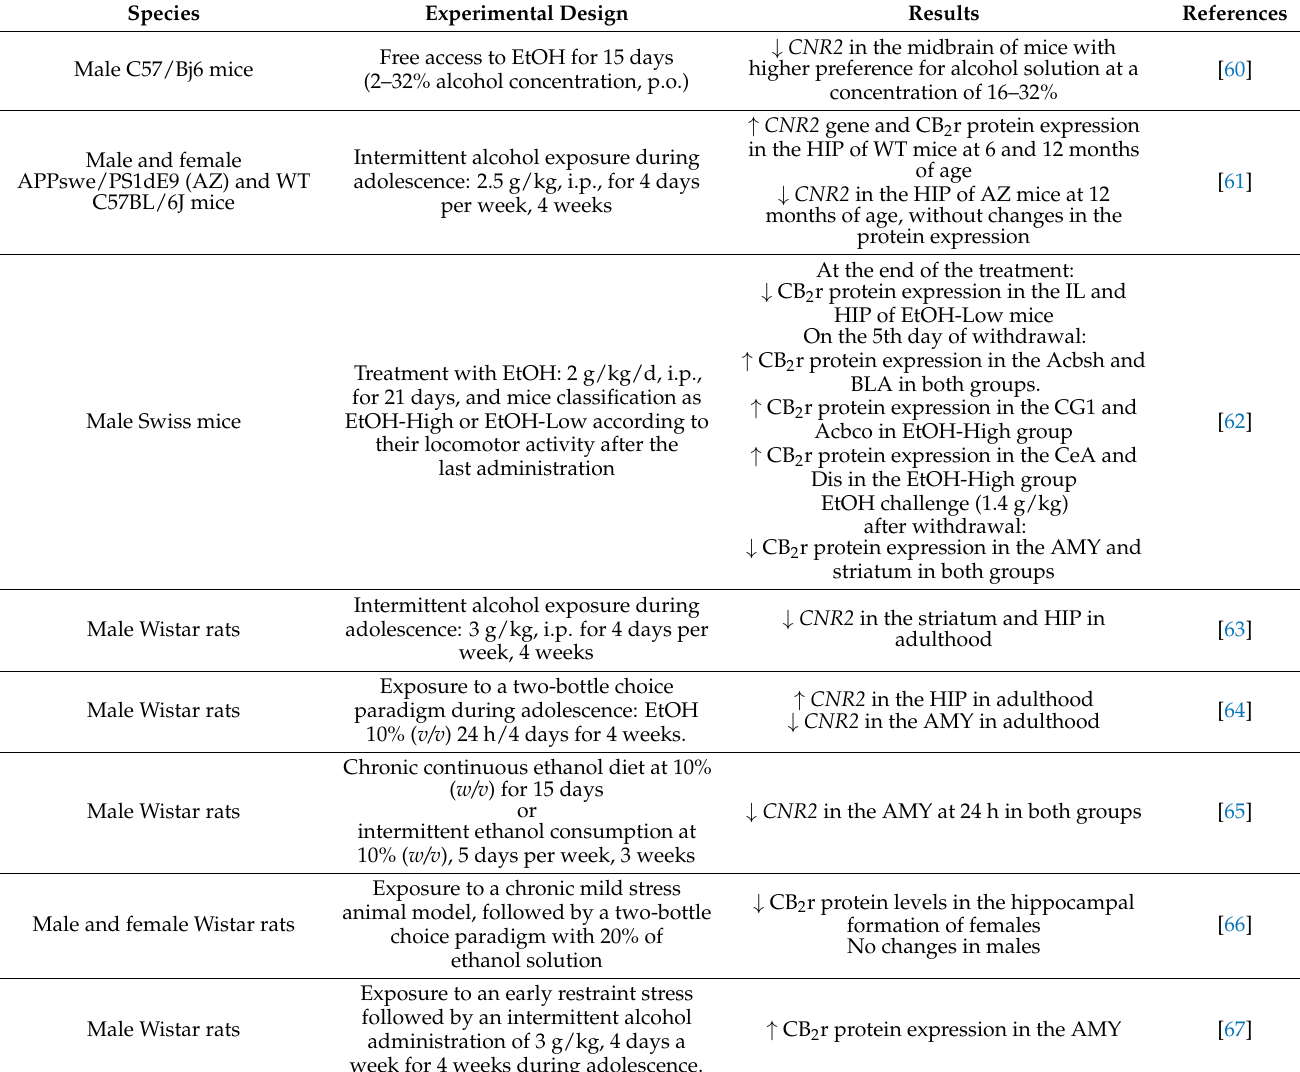
Table 1. CB 2 r alterations in brain regions of rodent models exposed to different regimens of alcohol